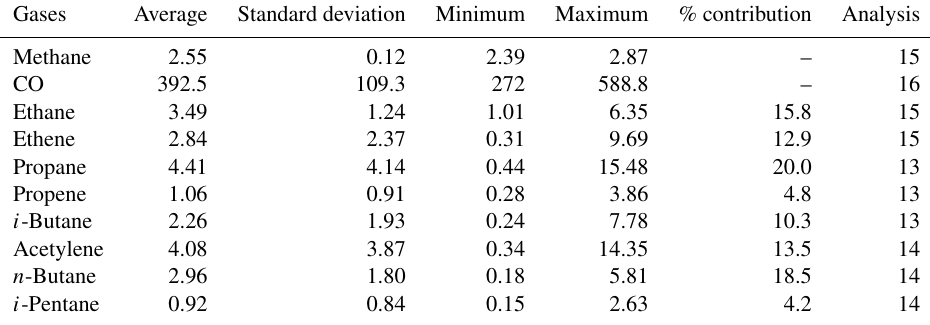
Table 3. Average, standard deviation, minimum and maximum mixing ratios (ppbv, except for CH 4 , which is in parts per million by volume) of CH 4 , CO and eight (C 2 -C 5 ) light NMHCs from the analysis of daily air sample collection from 30 December 2012 to 14 January 2013. Percentage contribution for each NMHC to the total of measured NMHCs is also